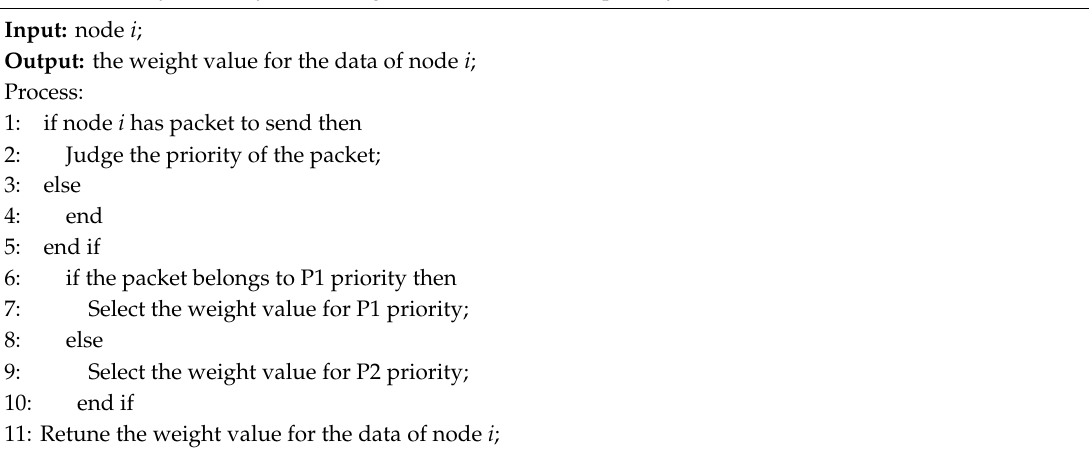
Algorithm 1: Dynamically select weight values for di ff erent priority